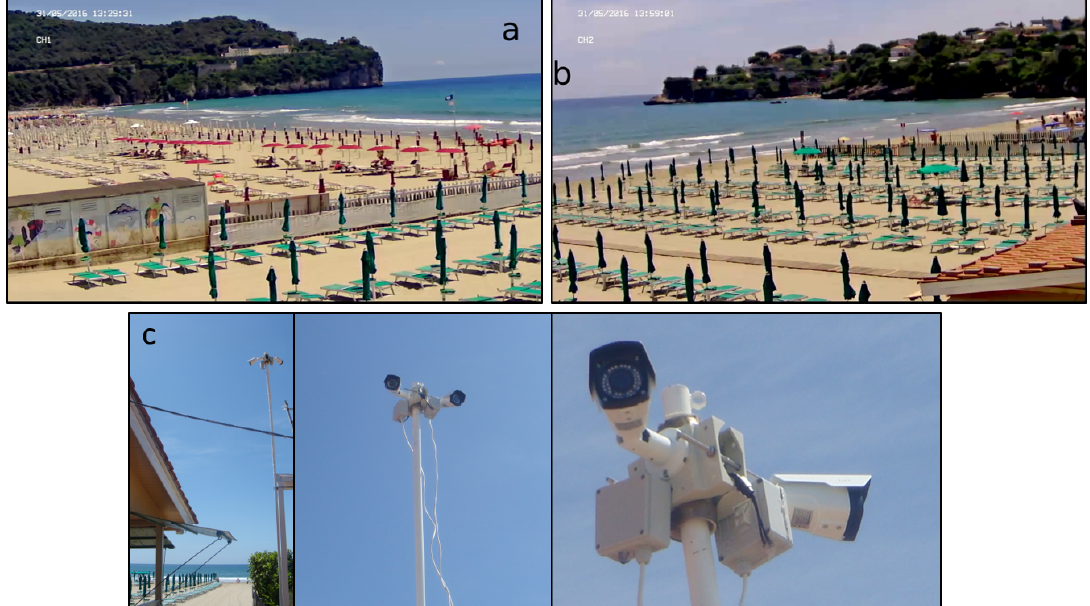
Figure 4. Camera system located on Serapo beach: ( a ) camera records, southeast side of the bay; ( b ) camera detections, west side of Serapo shoreline; ( c ) a detail of the camera